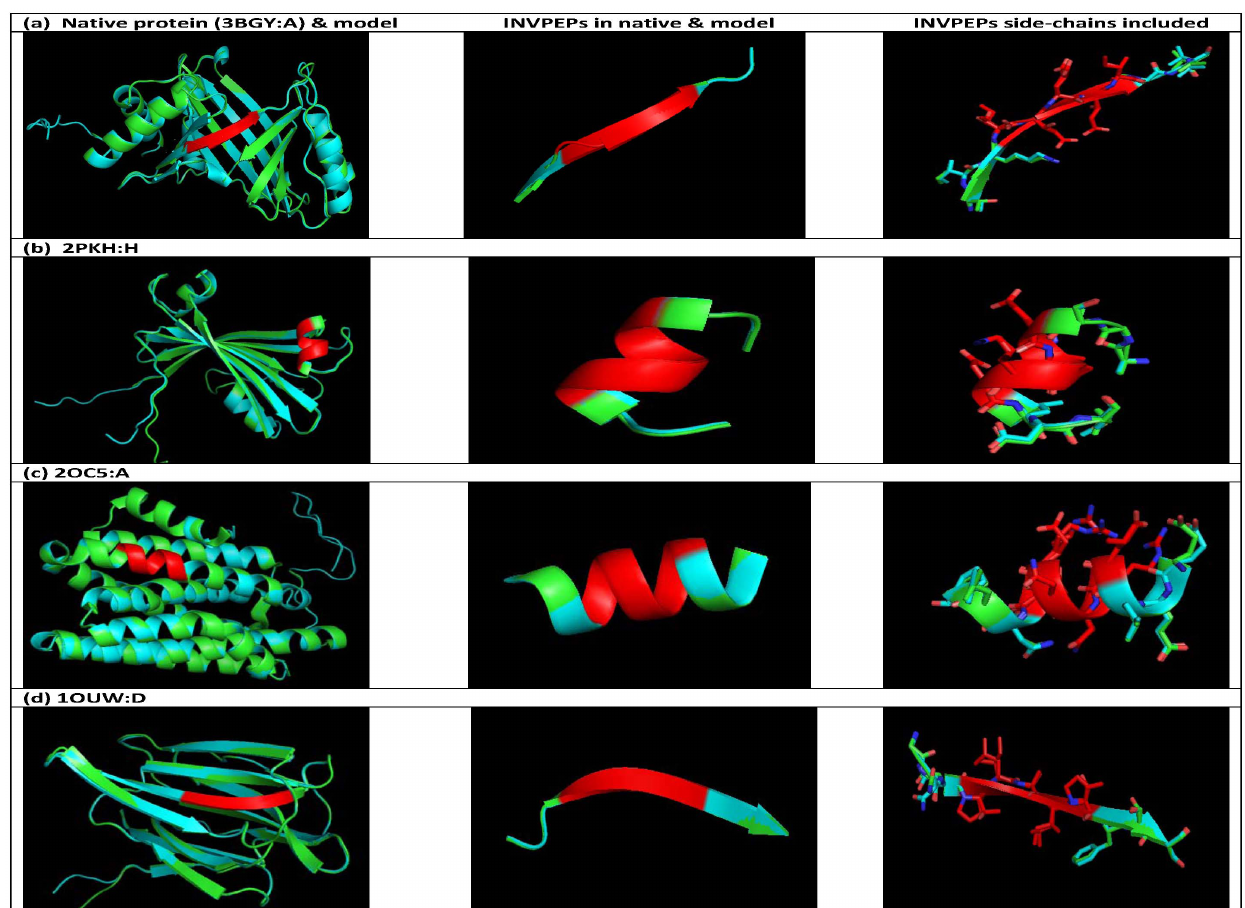
Figure 1. Schematic representation showing structural overlay of the ‘artificial’ proteins (cyan) modeled on the PDB templates (green); (a) 3BGY_A, (b) 2PKH_H, (c) 2OC5_A and (d) 1OUW_D. The secondary structure conformations corresponding to the inverted peptide, its corresponding peptide in the native protein, and the peptide amino acid residue side-chains are shown in the panels alongside.